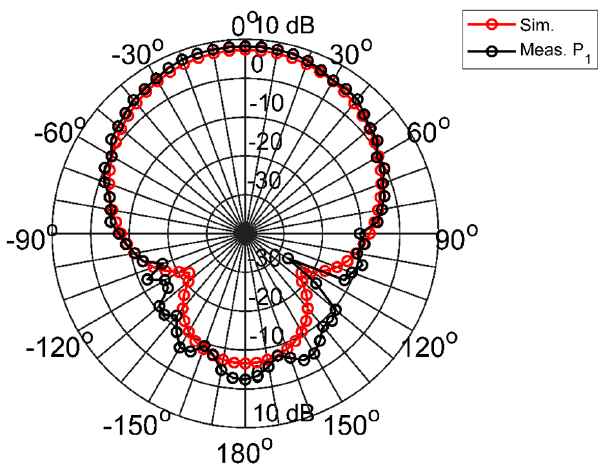
Figure 3. Electromagnetically coupled microstrip patch antenna’s simulated and measured radiation patterns in free-space at 2.45 GHz.